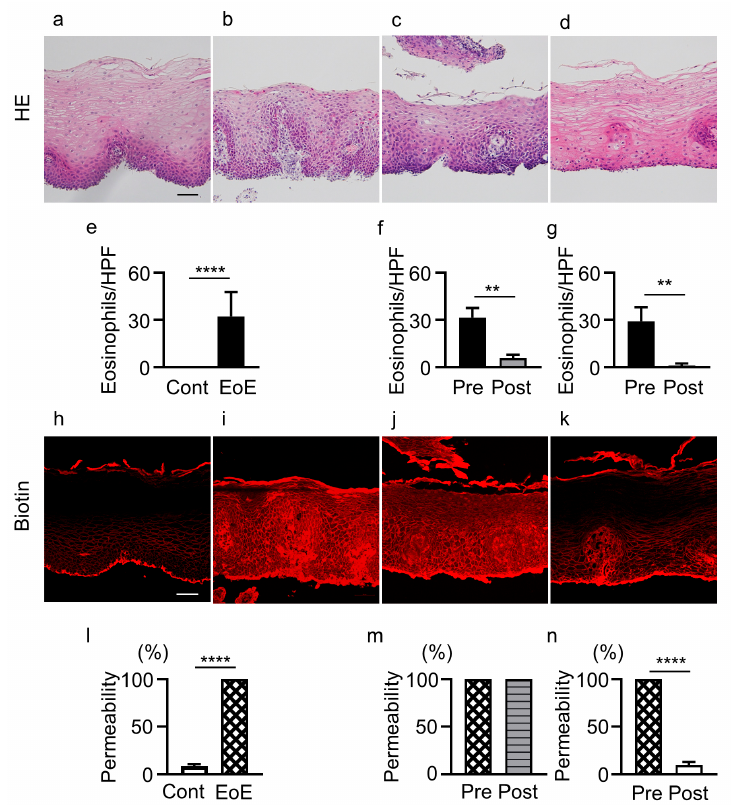
Figure 1. Infiltration of eosinophils and epithelial permeability in controls and EoE patients before and after treatment. ( a – d ) HE staining of biopsy sections. ( e – g ) Eosinophil counts in: controls (cont, n = 11) and EoE ( n = 11, ( e )), EoE before treatment (pre, n = 5) and after treatment (post, n = 5) among patients with unchanged permeability ( f ), and EoE before treatment (pre, n = 5) and after treatment (post, n = 5) among patients with decreased permeability ( g ). ( h – k ) Sections stained with biotin (red). ( l ) Percentage of biotinylation of controls ( n = 11) and EoE before treatment ( n = 11). ( m , n ) Esophageal epithelial permeability of EoE patients with unchanged permeability ( n = 5, ( m )) and decreased permeability ( n = 5, ( n )) after treatment. Representative HE and biotin staining of samples from controls ( a , h ), EoE patients before treatment ( b , i ), EoE patients with unchanged permeability after treatment ( c , j ), and EoE patients with decreased permeability after treatment ( d,k ). Data are expressed as mean ± standard deviation. EoE, eosinophilic esophagitis; HE, hematoxylin and eosin; HPF, high-power field. ** p < 0.01, **** p < 0.0001. Bar = 50 µ